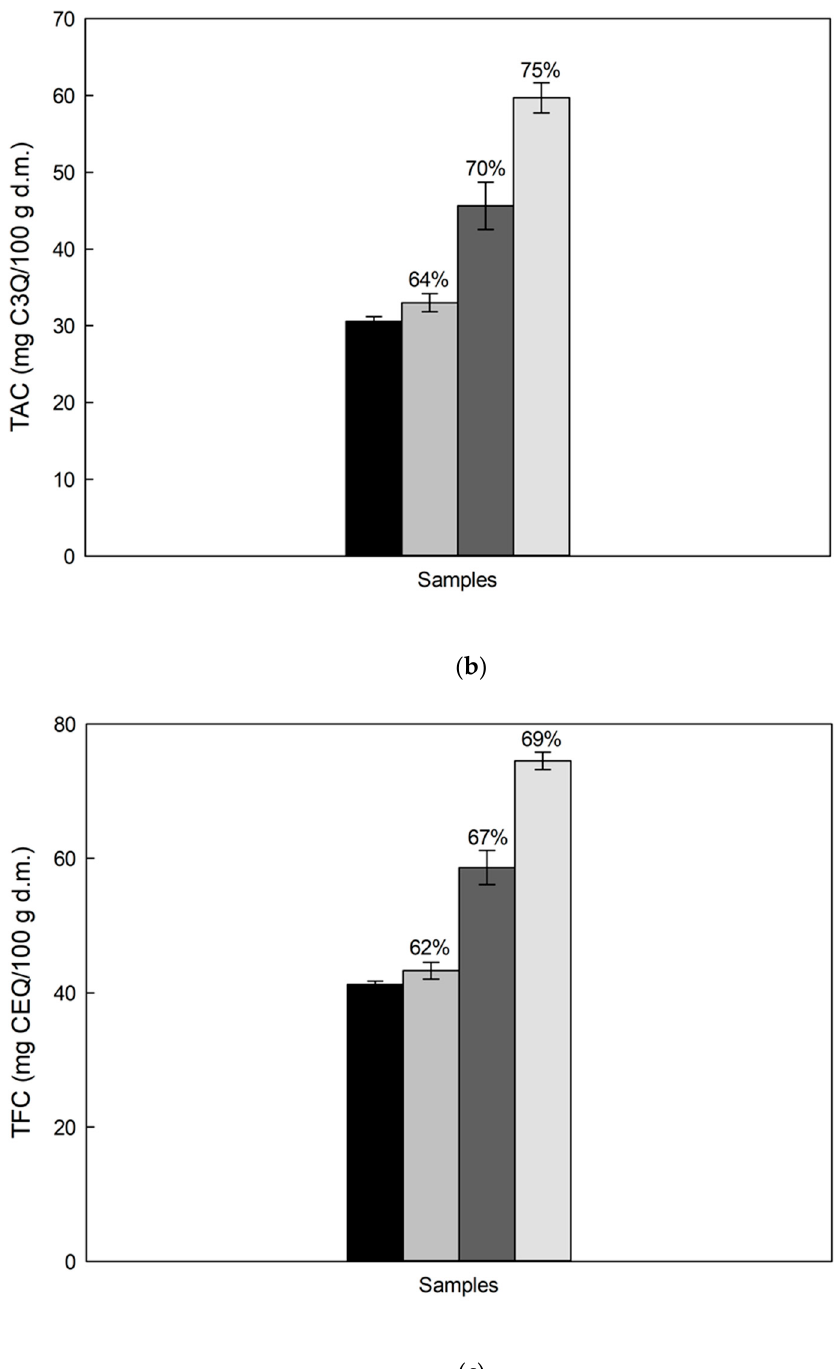
Figure 2. Polyphenolic compounds in samples: ( a ) TPC; ( b ) TAC; ( c )